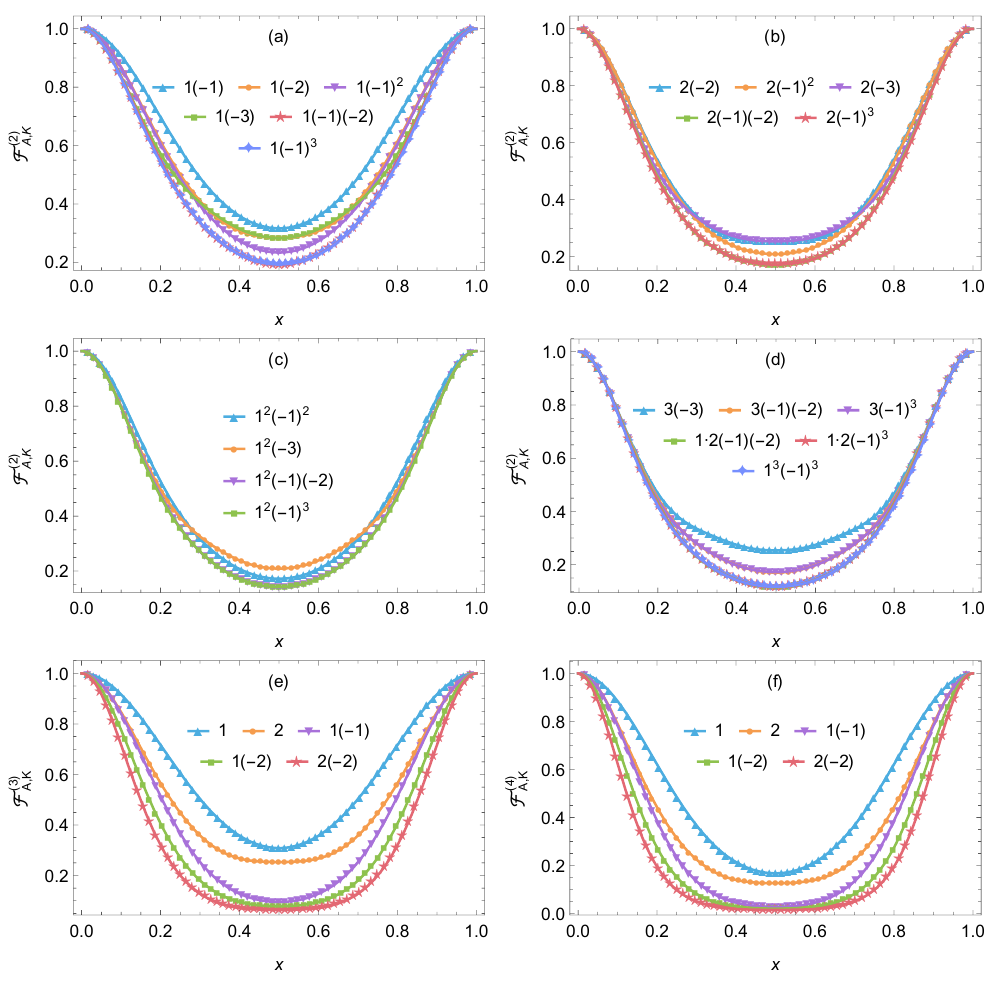
Figure 2 . The second, the third and the fourth Rényi entropies in the excited states of the 2D free massless non-compact bosonic theory (lines) and the gapless limit of the harmonic chain (symbols). We have set m = 10 − 5 , L = 64